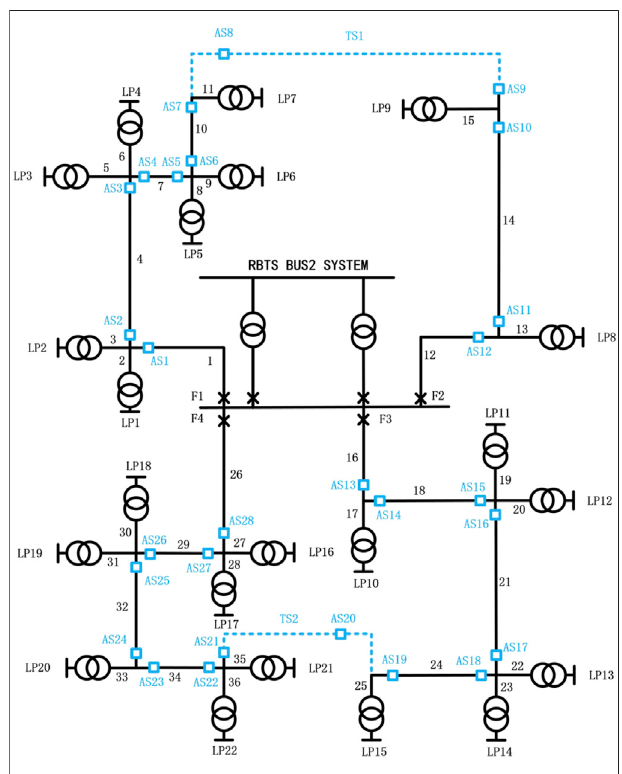
FIGURE 3 | Bi-level optimization fl ow chart.